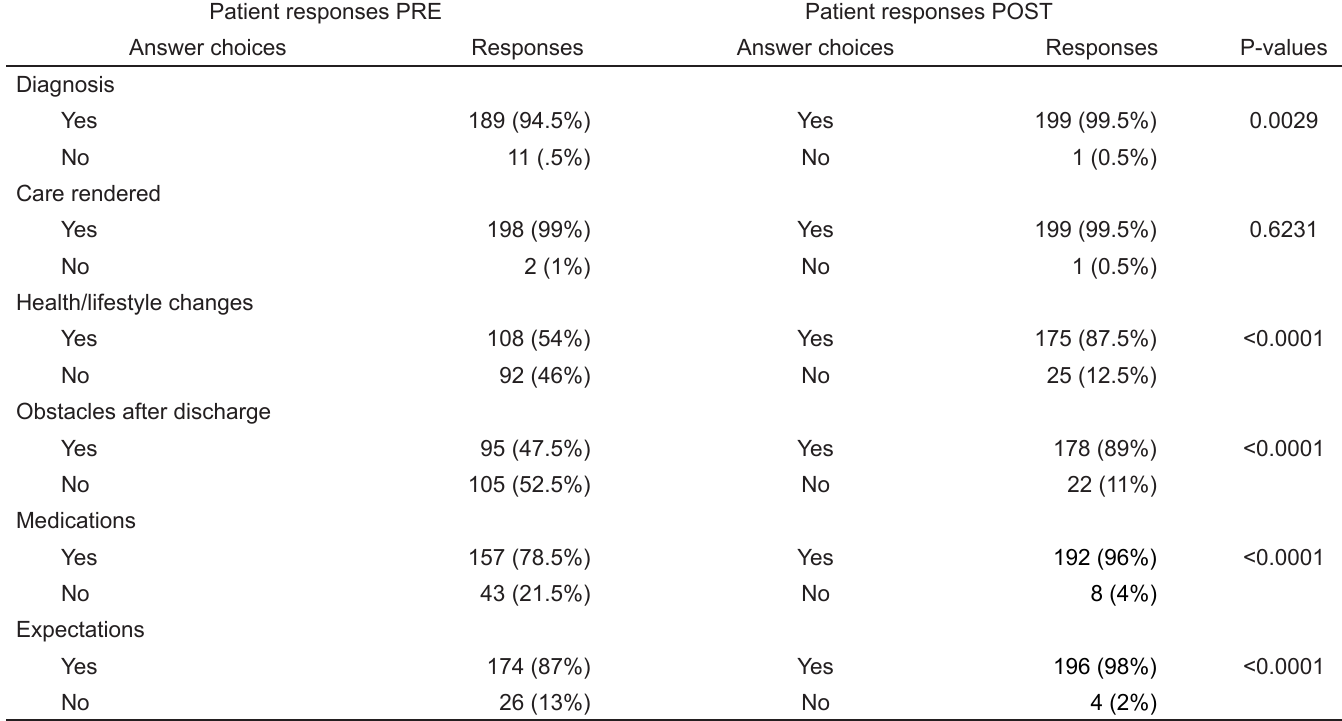
Differences between pre- and post-intervention were analyzed with Fisher’s exact test. P-values ≤0.05 were considered as statistically